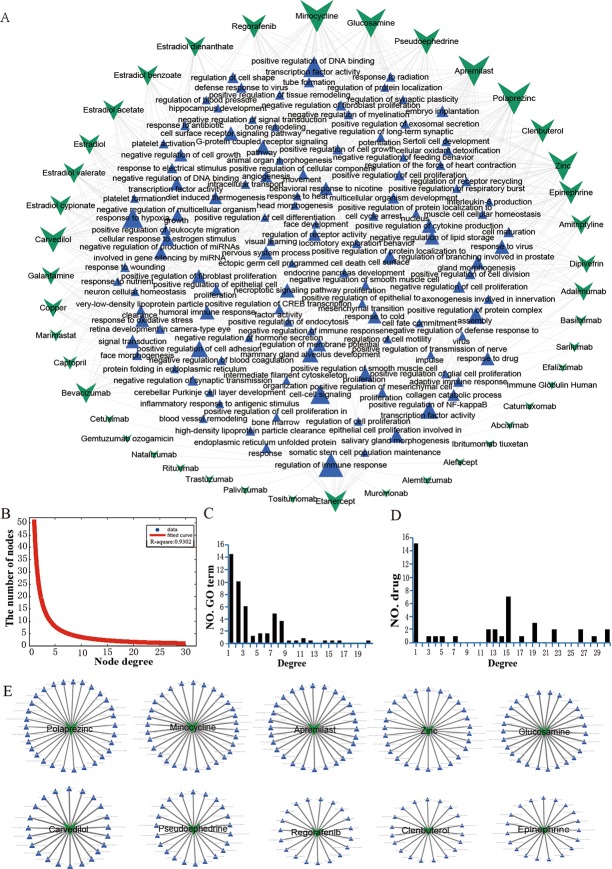
The relationship between drugs and GO functions.(A) Drug-GO function network (DGOFN) in MG. Network organization of drug and GO function associations. Green ‘V’ formations represent drugs; blue triangles represent GO functions. The size of the node represents the size of the degree; edge represents the connection between drugs and GO functions. (B) Degree distribution for all nodes in the DGOFN. (C) Degree distribution for the GO function nodes. (D) Degree distribution for the GO nodes. (E) The top 10 drugs ranked by drug degree (Polaprezinc, Minocycline, Apremilast, Zinc, Glucosamine, Carvedilol, Pseudoephedrine, Regorafenib, Clenbuterol and Epinephrine).